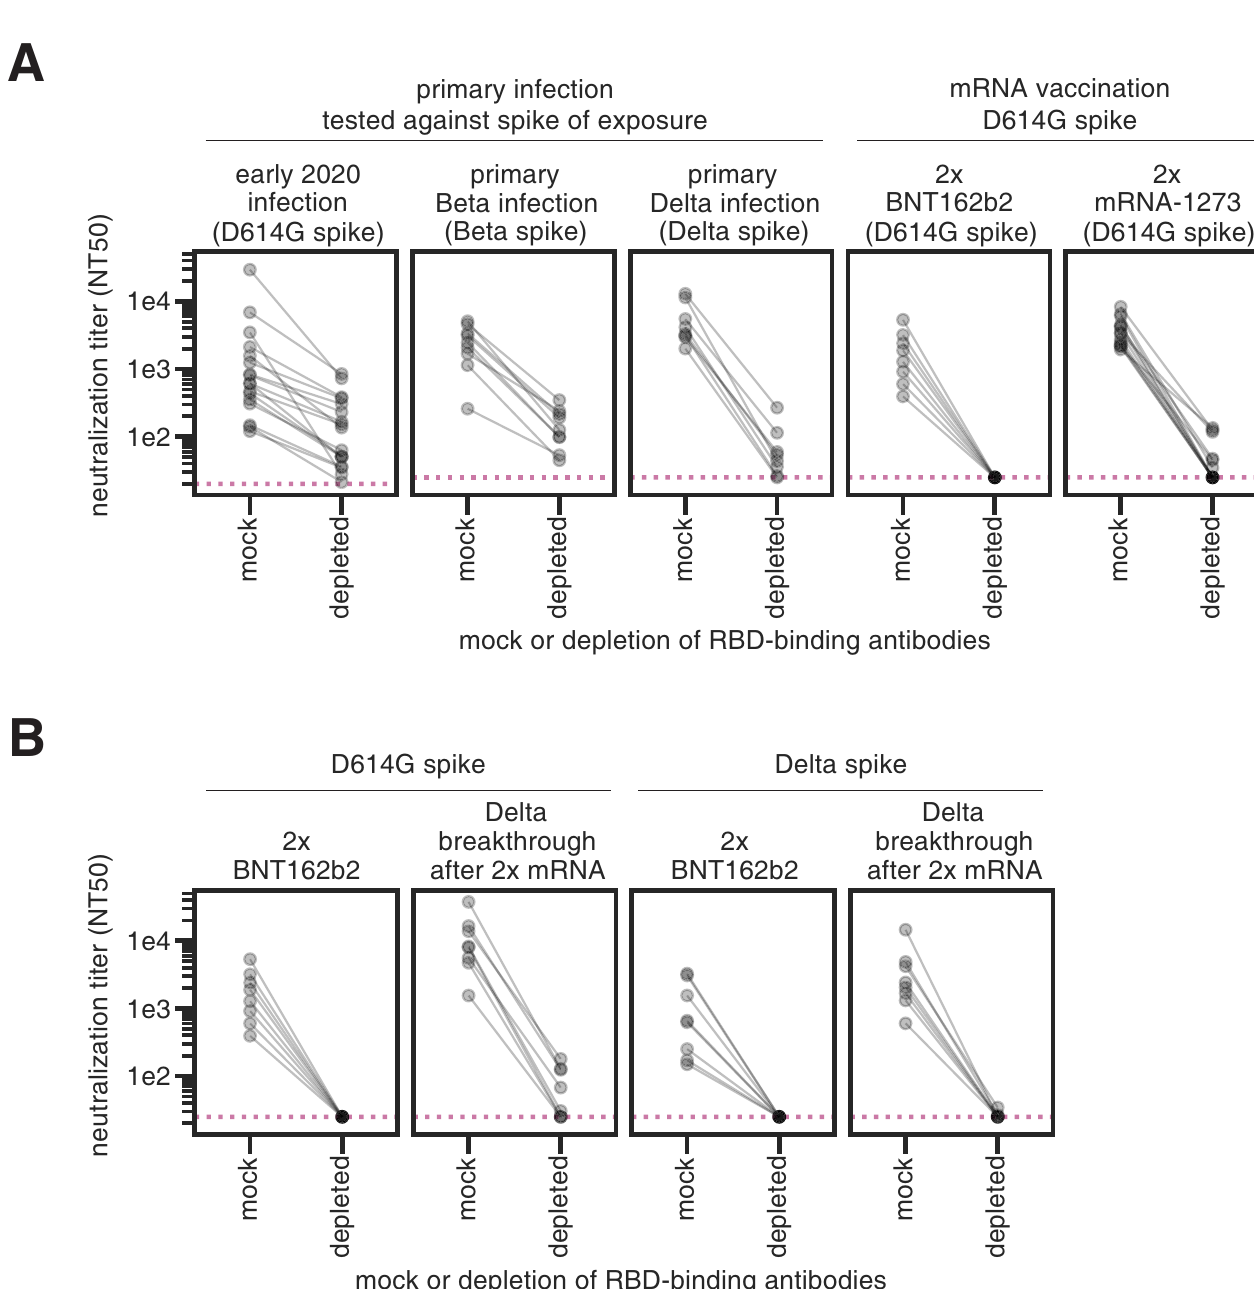
Fig 2. SARS-CoV-2 infection or vaccination elicits a neutralizing antibody response highly focused on the RBD. (A) Plasma neutralization (neutralization titer 50%, NT50) against lentiviral particles pseudotyped with the homologous spike of exposure (in parentheses) following either mock depletion or depletion of RBD-binding antibodies for individuals who had primary infections with early 2020, Beta, or Delta viruses (and no prior SARS-CoV-2 infections or vaccinations), or individuals who completed the two-dose series of the mRNA vaccines BNT162b2 or mRNA-1273 (labeled 2x BTN162b2 or 2x mRNA-1273). (B) Plasma neutralization following either mock depletion or depletion of RBD-binding antibodies for individuals who were vaccinated 2x with BNT162b2 or who had Delta breakthrough infections after 2x mRNA vaccination. Plasma samples were depleted of D614G RBD-binding antibodies and tested for neutralization against D614G spike (left), or depleted of Delta RBD-binding antibodies and tested for neutralization against Delta spike (right). In all cases, the RBD and spike from the same viral variant were used in both the depletions and neutralization assays. Note that the same 2x BNT162b2 data are shown in the right panel of (A) and in the left panel of (B) to facilitate visual comparison. The neutralizing titers for the early 2020 plasmas were first published in [23], the Beta plasmas in [12], and the 2x mRNA-1273 plasmas in [29]. The assays for the primary Delta infection, Delta breakthrough infection, and 2x BNT162b2, with both D614G and Delta RBD and spike were newly performed in this study. ELISAs that confirm depletion of RBD-binding antibodies performed in this study are in S1 Fig . The results new to this study are plotted by individual serum or plasma in S2 Fig . Full neutralization curves are shown in S7 Fig .